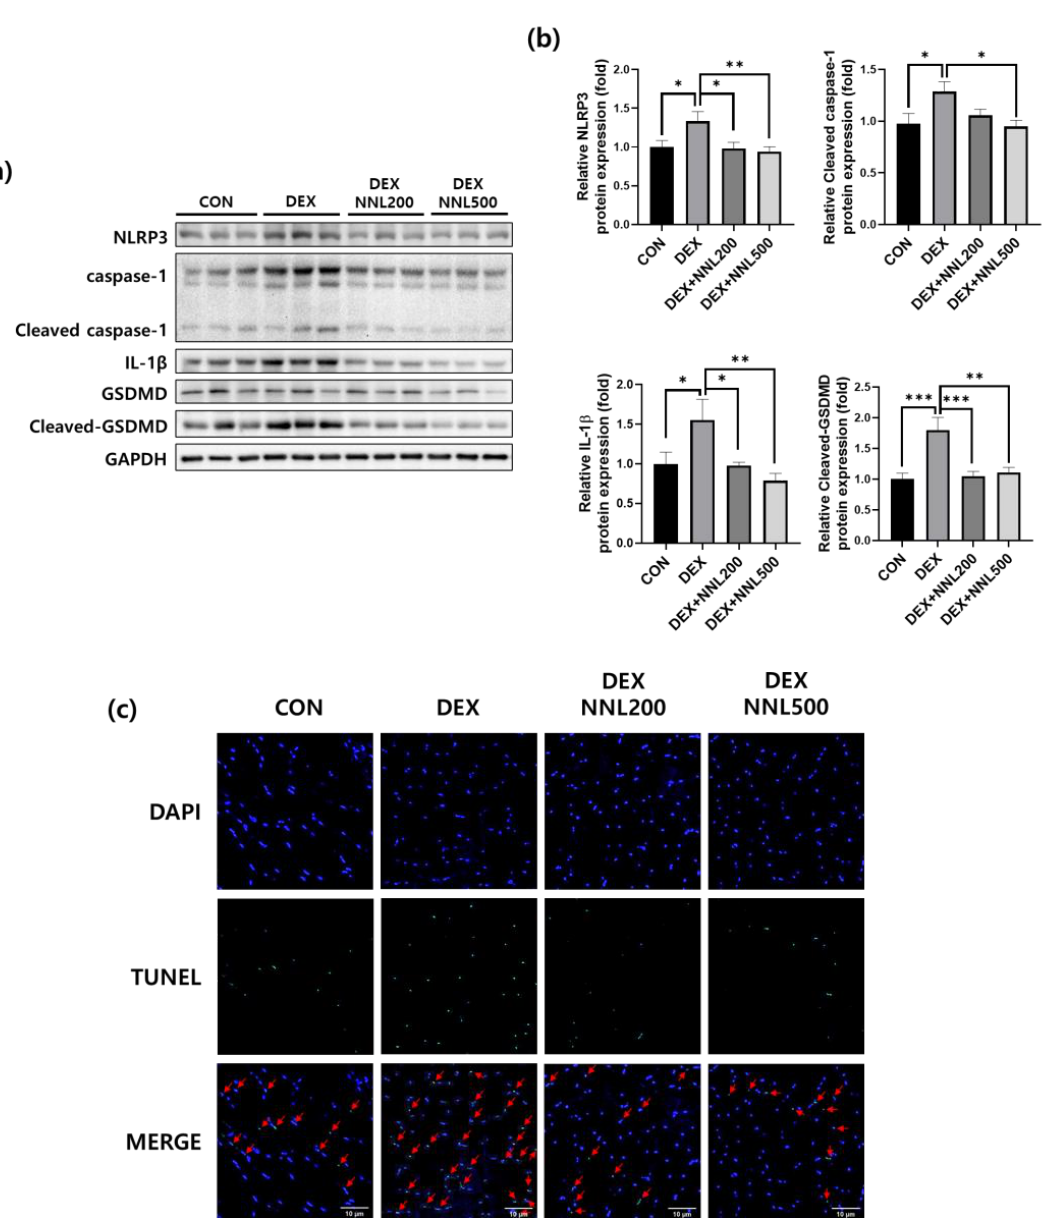
Figure 6. The NNL extract administration inhibited pyroptosis in DEX − induced muscle atrophy in mice. The protein expression levels of NLRP3, Caspase − 1, IL −1β, or GSDMD in the QD muscle were analyzed by immunoblotting. GAPDH was used as an internal control. ( a ) Representative images are shown. ( b ) NLRP3, cleaved caspase − 1, IL −1β, cleaved− GSDMD immunoblots were quantified in Figure 6a using ImageJ software and normalized to GAPDH. Data are shown as mean ±S.E.M., n = 6/group; * p < 0.05, ** p < 0.01, *** p < 0.001. ( c ) TUNEL staining of the QD muscle sections. Representative images are shown (original magnification, 400 × ; n = 5/group). DAPI (blue) and TUNEL − positive cells (green). The red arrows indicate TUNEL − positive cells.